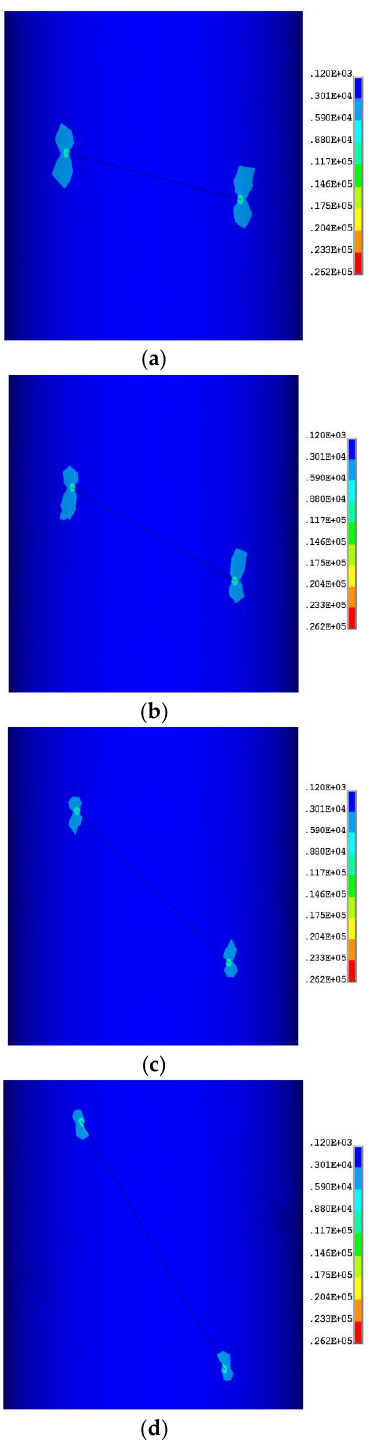
Figure 22. Von Mises Stress diagram for cracks with different oblique angles (Pa). ( a ) inclined crack angle ϕ = 75 ◦ , ( b ) inclined crack angle ϕ = 60 ◦ , ( c ) inclined crack angle ϕ = 45 ◦ , ( d ) inclined crack angle ϕ = 30 ◦